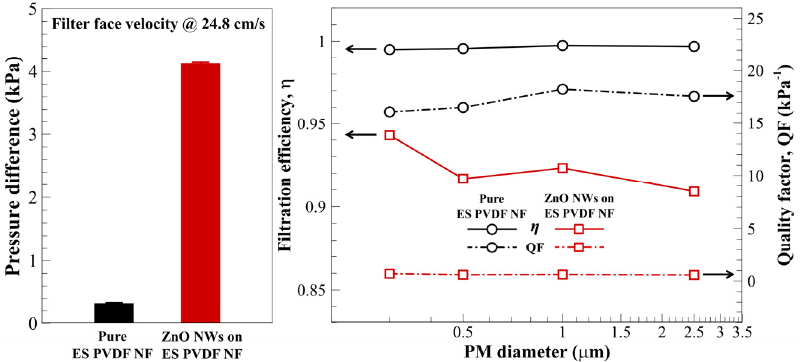
Figure 7. PM Filtration performance analysis of electrospun PVDF NF layer, with and without ZnO NWs, via measurement of pressure difference ( Δ P ), filtration efficiency ( η ), and quality factor (QF). The Δ P of the ZnO NWs-PVDF NF layer shows 4.129 ± 0.0175 kPa, which is 12.5 times